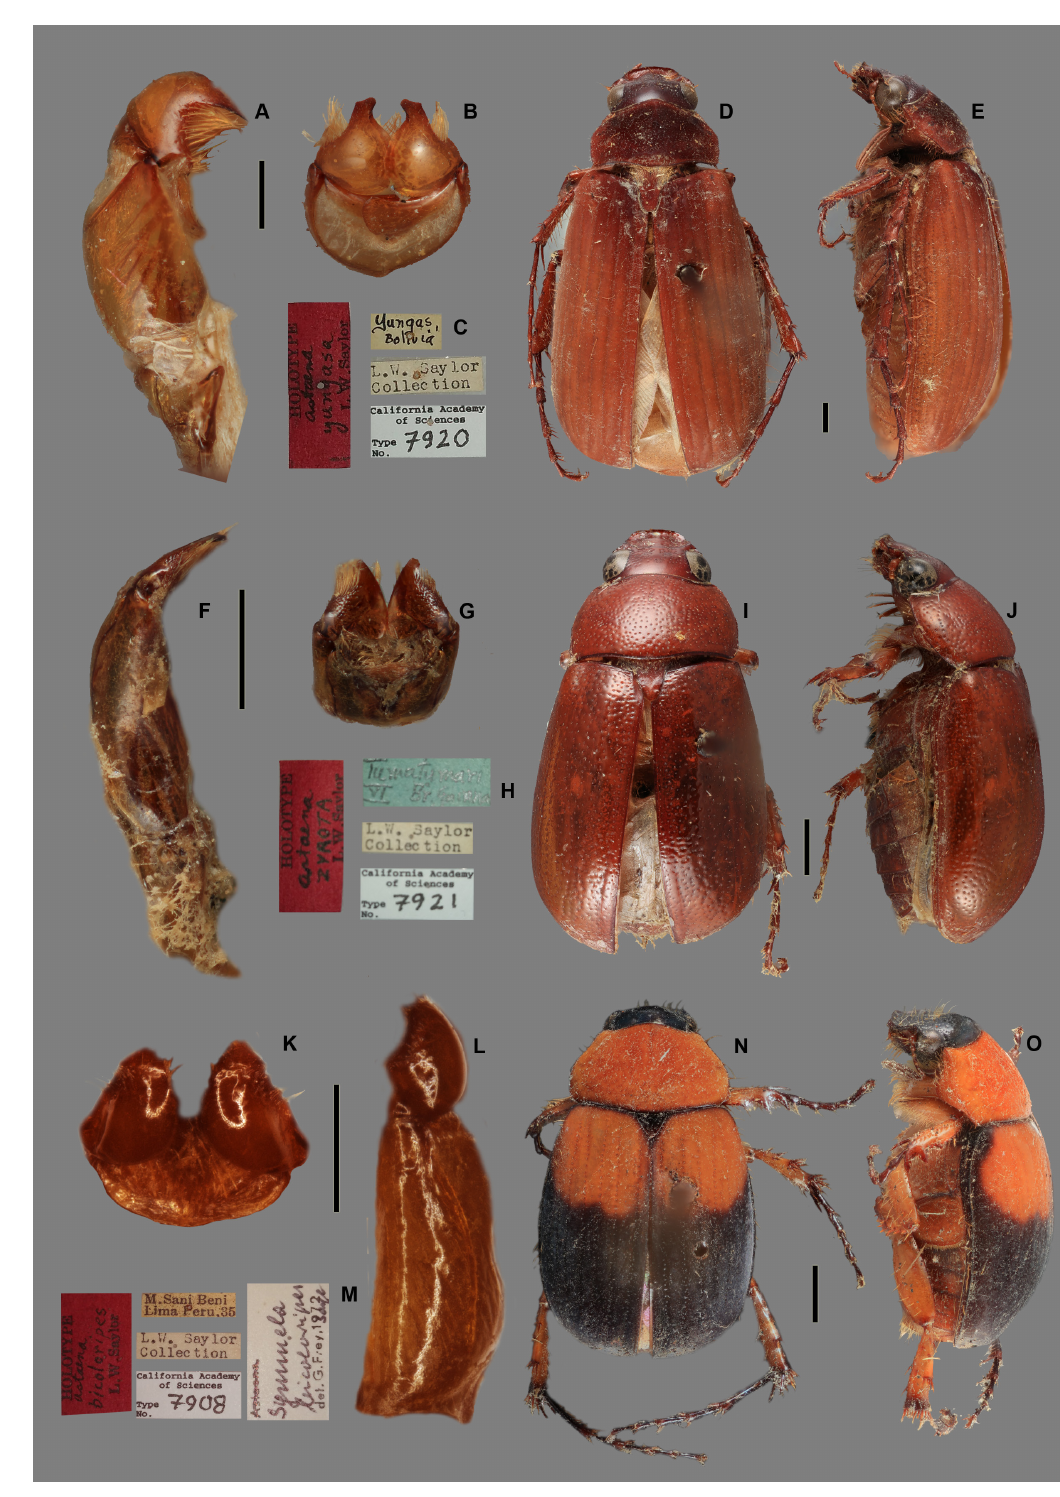
Fig. 5. A–E . Astaena yungasa Saylor, 1946, holotype, ♂ (Type No. 7920; CAS). – F–J . A. zyrota Saylor, 1946, holotype, ♂ (Type No. 7921; CAS). – K–L . Sayloria bicoloripes (Saylor, 1946), paratype, ♂ (CAS). – M–O . S. bicoloripes , holotype, ♀ (Type No. 7908; CAS). A, F, L . Aedeagus, lateral view. B, G, K . Parameres, dorsal view. C, H, M . Labels. D, I, N . Habitus, dorsal view. E, J, O . Habitus, lateral view. Scale bars: A–B, F–G, K–L = 0.5 mm; D–E, I–J, N–O = 1